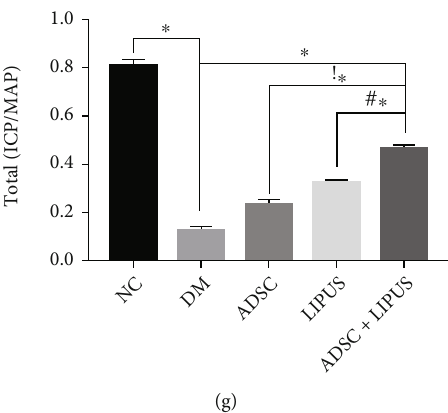
Figure 2: Erectile function at 4 weeks after the initiation of treatment. (a – e) Representative intracavernous pressure (ICP) responses to cavernous nerve (CN) electrostimulation from the NC, DM, ADSC, LIPUS, and ADSC+LIPUS groups. The red bar denotes the 50- second CN electrical stimulation. (f, g) The ratios of maximal ICP to mean arterial pressure (MAP) and total ICP to total MAP were recorded. Data are presented as the mean ± standard deviation. ∗ p < 0 : 05 when comparing the NC group. ! ∗ p < 0 : 05 when comparing the ADSC group. # ∗ p < 0 : 05 when comparing the LIPUS